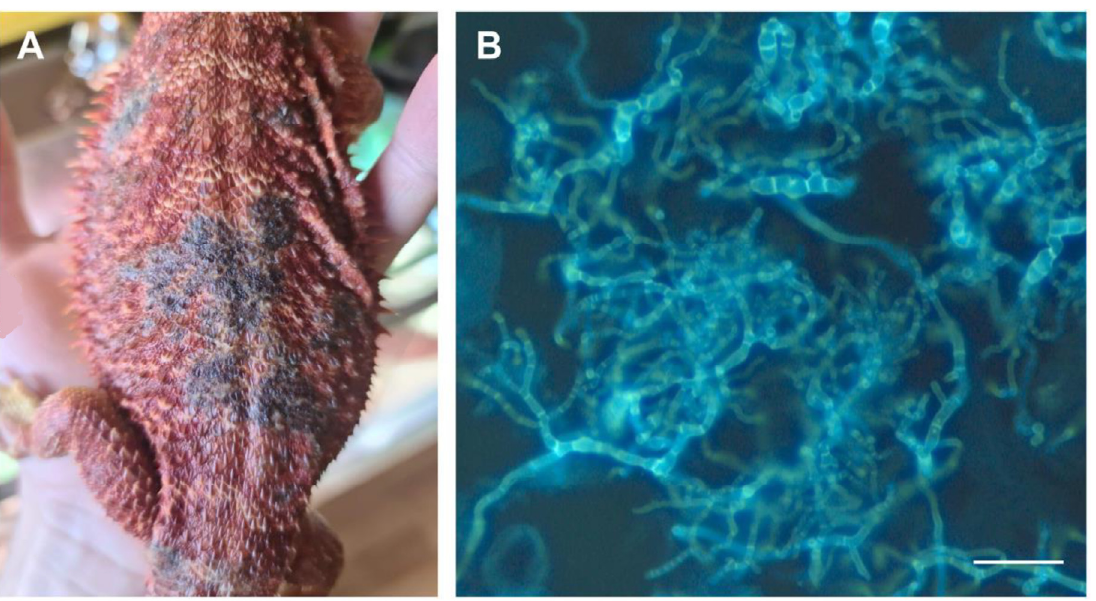
Figure 2. Nannizziopsis guarroi in a pogona ( A ) and direct mycological examination ( B ). The sample preparations were observed with a fluorescence microscope using excitation between 360 and 400 nm (bar = 20 µ m).